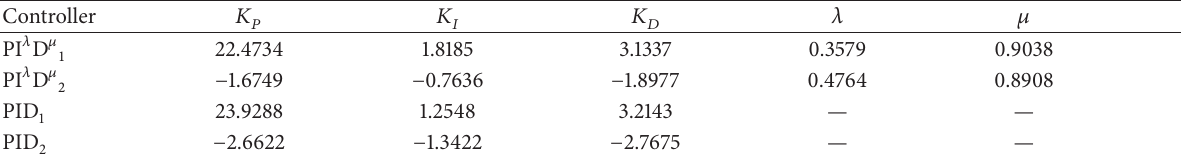
Table 5: Values of controller parameters.